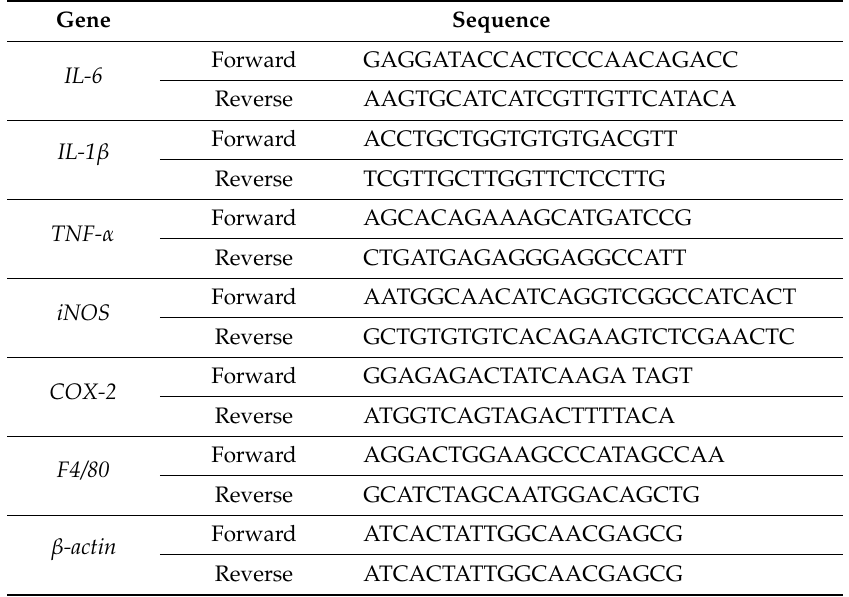
Table 4. List of primers.